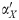
Results for 15 datasets with no underlying association: Data from different EEG recordings was taken and the channel (electrode position) was picked at random.As two different recordings must not have any underlying association, BPA was checked for different combinations of αX′ and αY′ and it was found that the results were pretty low. The figure is arranged in exactly the same way as Figs 5 and 9 datasets have been shown. Below every heatmap, a scatterplot of the actual data is shown. Also, a black line shows the relationship function that was calculated by curve fitting approaches. On the top left of the heatmap, the unique index of every dataset is presented. On the top of the heatmap Pearson correlation coefficient (PC) along with the p-value in brackets and the normalized mutual information content (MI) for the dataset is given. On the top of the scatterplot, the Spearman rank correlation coefficient (SR) and the Kendall tau rank correlation coefficient (KT) are given.